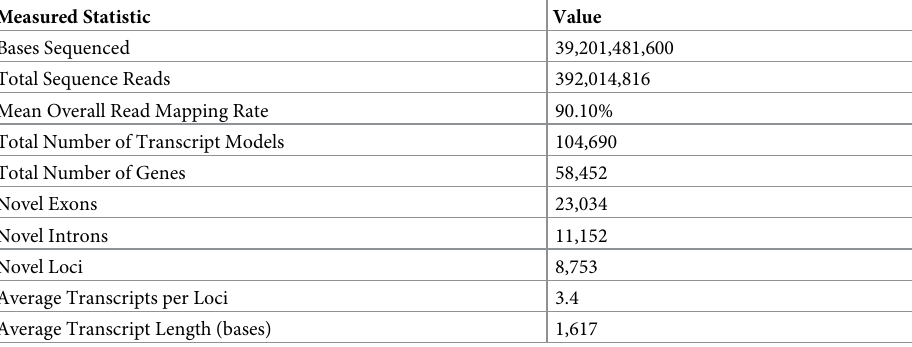
Table 1. Sequencing and transcriptome assembly